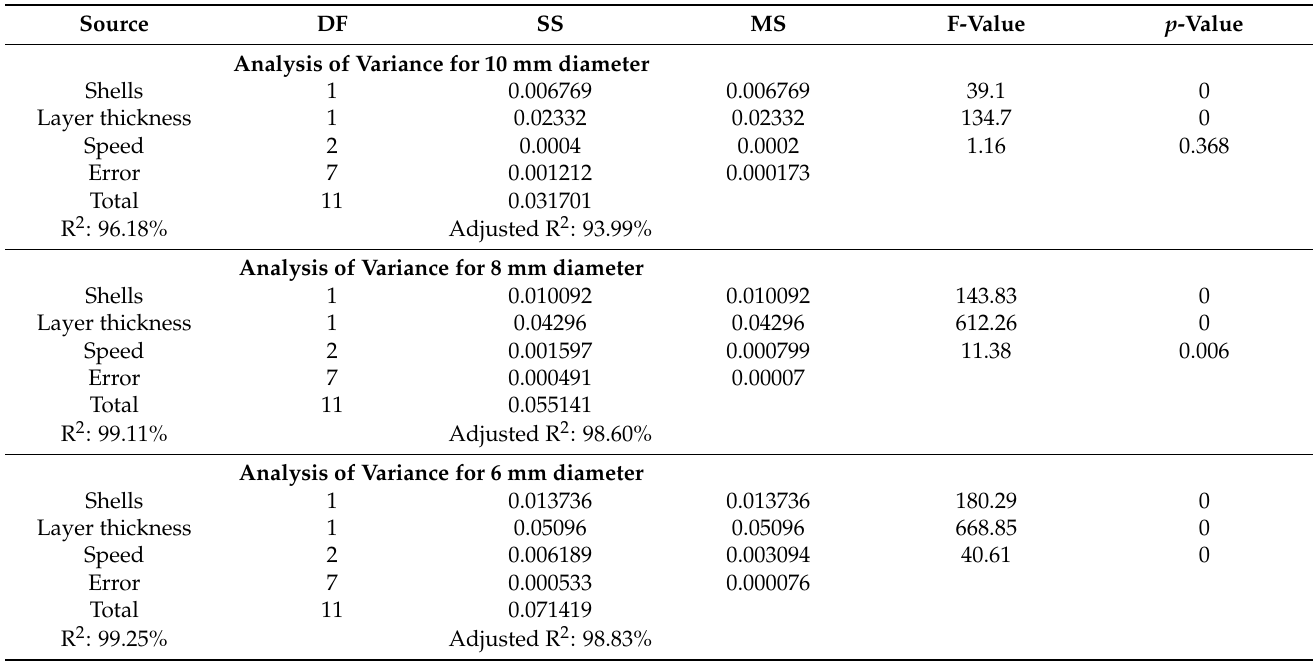
Table 5. ANOVA results for holes’ mean diameters